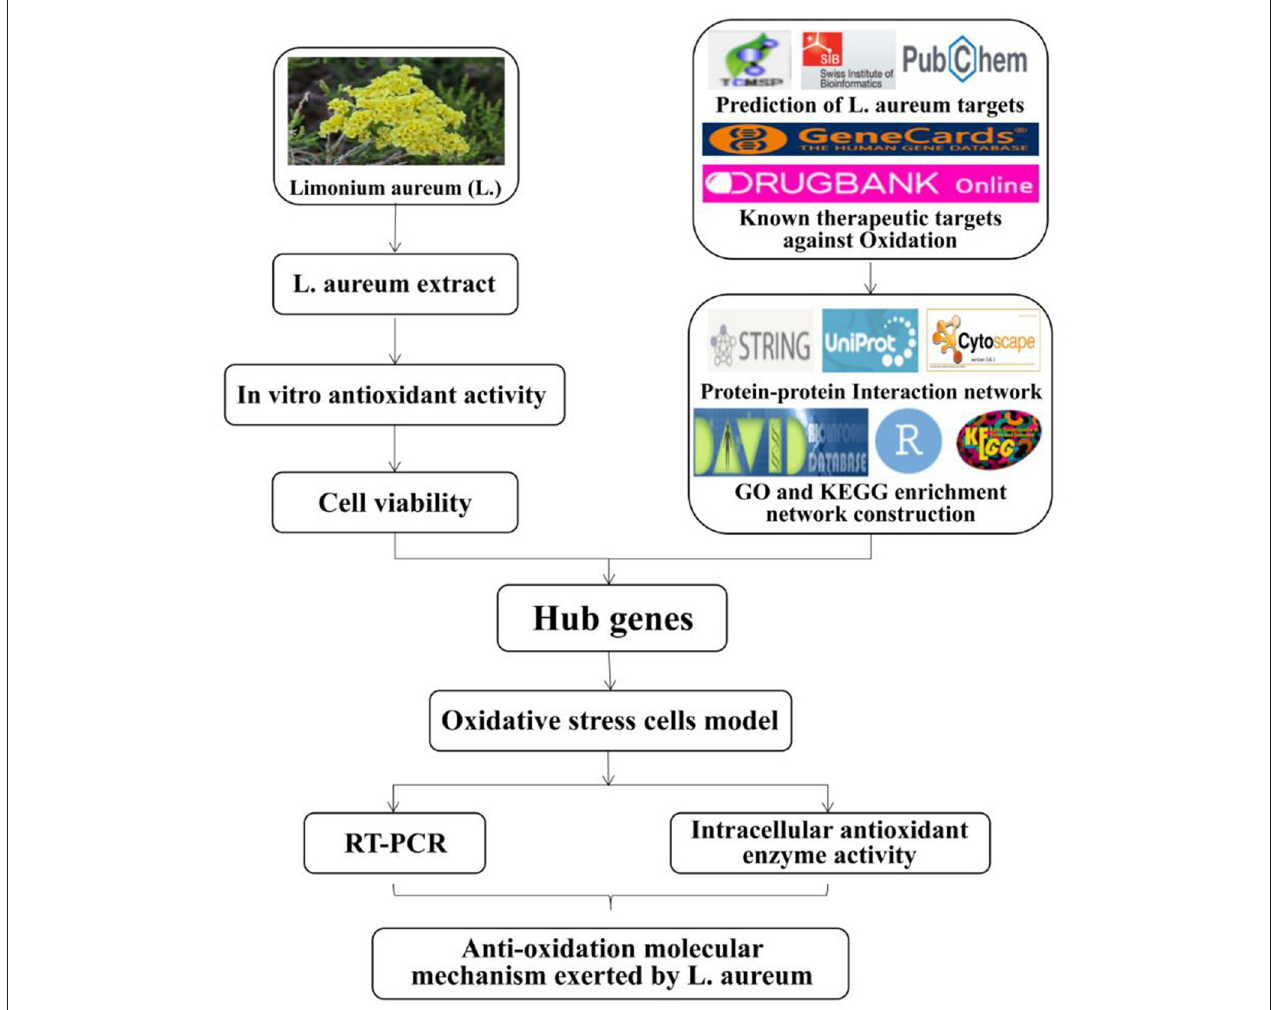
FIGURE 1 | The roadmap of L. aureum extract for the treatment of